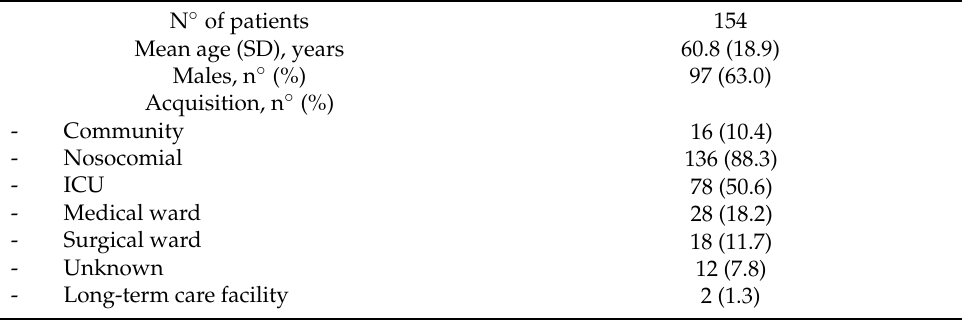
Table 1. Demographic, clinical and microbiological characteristics of the patients